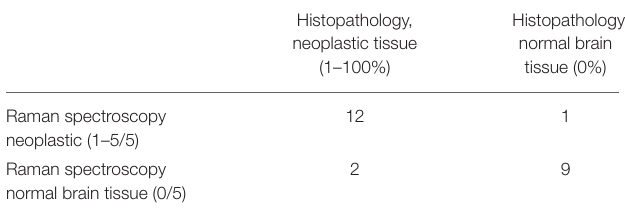
TABLE 2 | Two by two table of Raman spectroscopy and histopathology sample results which was utilized to calculate sensitivity, specificity, and accuracy of Raman spectroscopy compared to